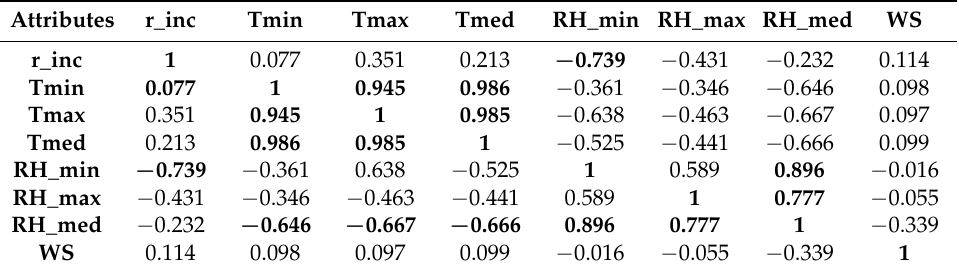
Table 16. Task 5: the correlation matrix for the clustering attributes